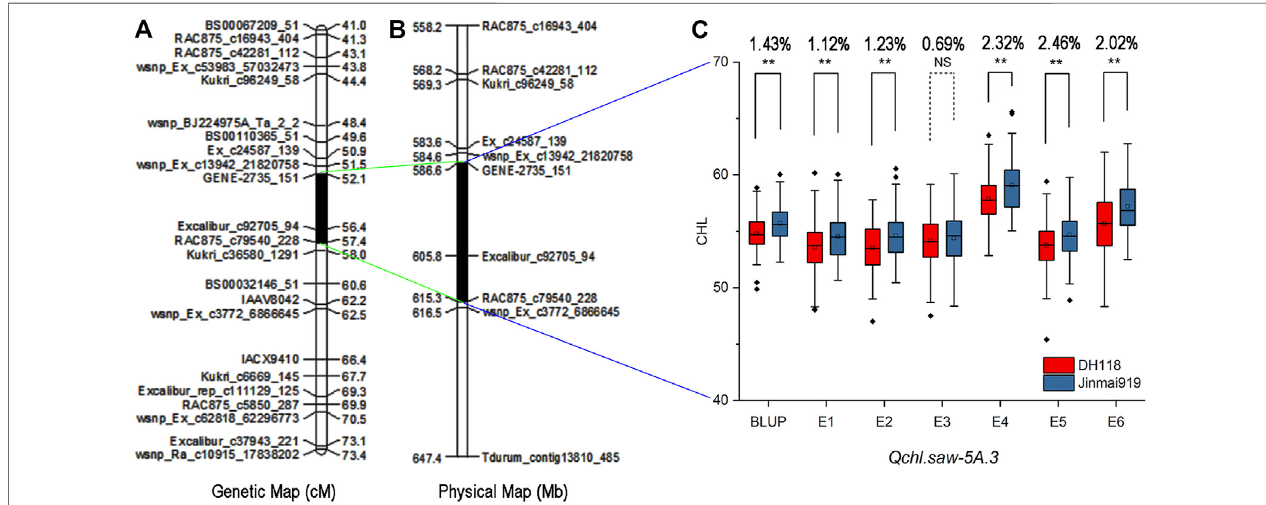
FIGURE 3 | Genetic map of the major QTL Qchl.saw-5A.3 and its effect. (A) Genetic map of Qchl.saw-5A.3 for chlorophyll content. (B) Physical map of fl anking markers of Qchl.saw-5A.3 . (C) Effect ofthe QTL shown as box plots calculated after dividing the DJpopulation into two classes based on the fl anking markers. * and **, p < 0.05 and p < 0.01, respectively; NS, not signi fi